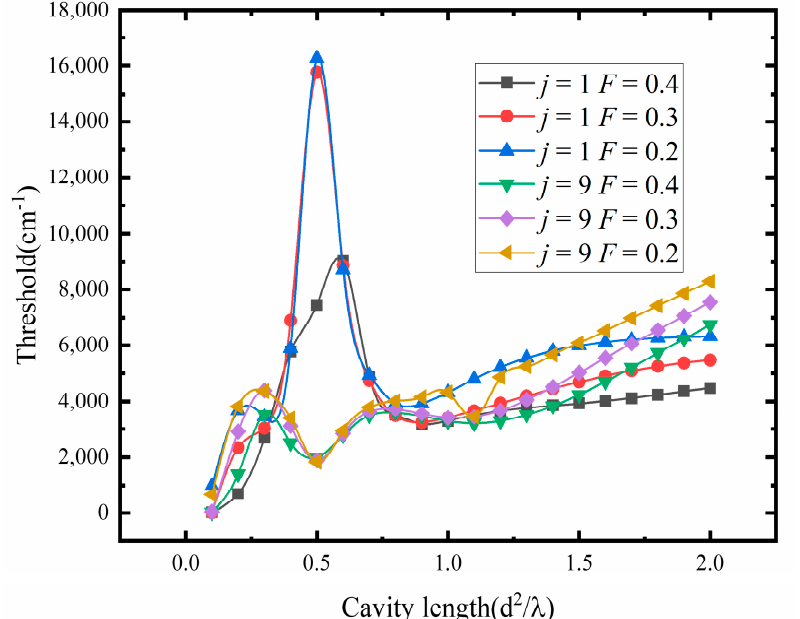
Figure 6. The changes of thresholds relative to duty ratio F of lowest supermode and highest order